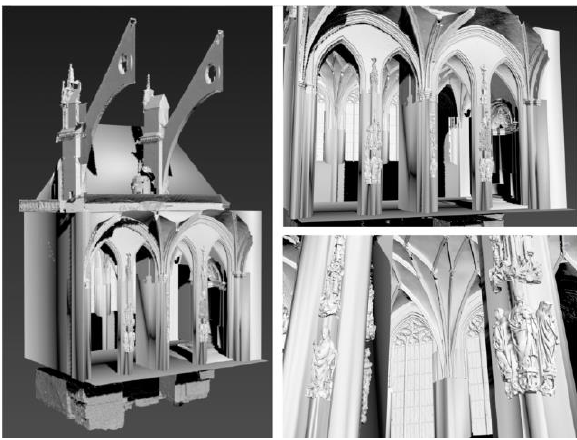
Figure 6. Combination of geometric primitives and meshed parts for the final 3D model of the Chapel.